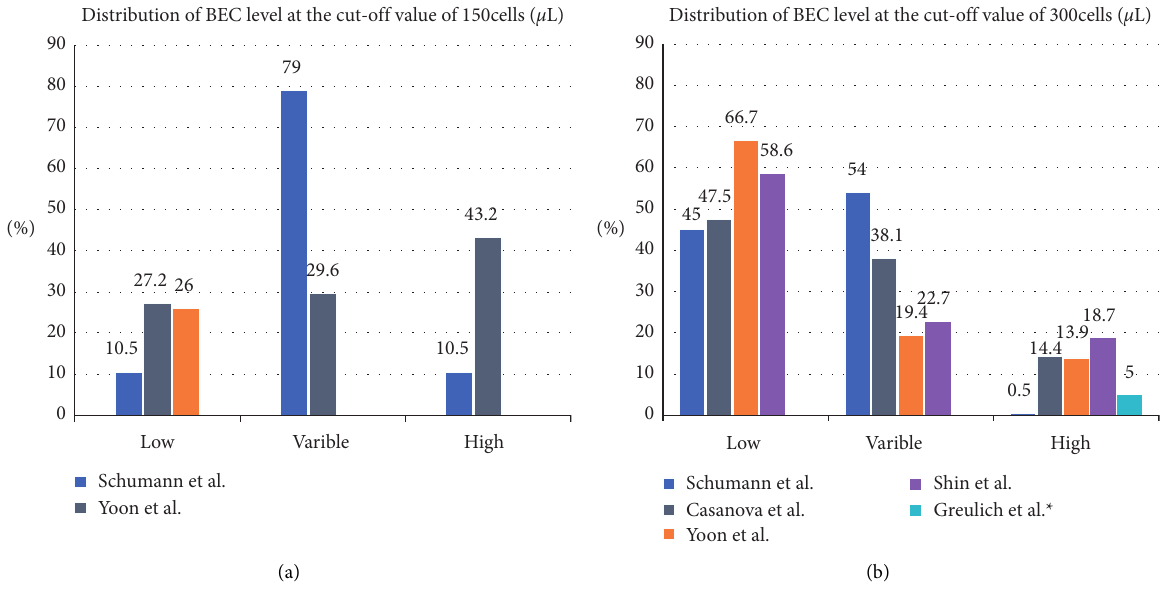
Figure 3: (a). Distribution of BEC level at the cutoff value of 150 cells/ μ L. ∗ The variable and high group was absent in the study launched by Greulich et al. (b) Distribution of BEC level at the cutoff value of 300 cells/ μ L. ∗ The variable and low group was absent in the study launched by Greulich et al.